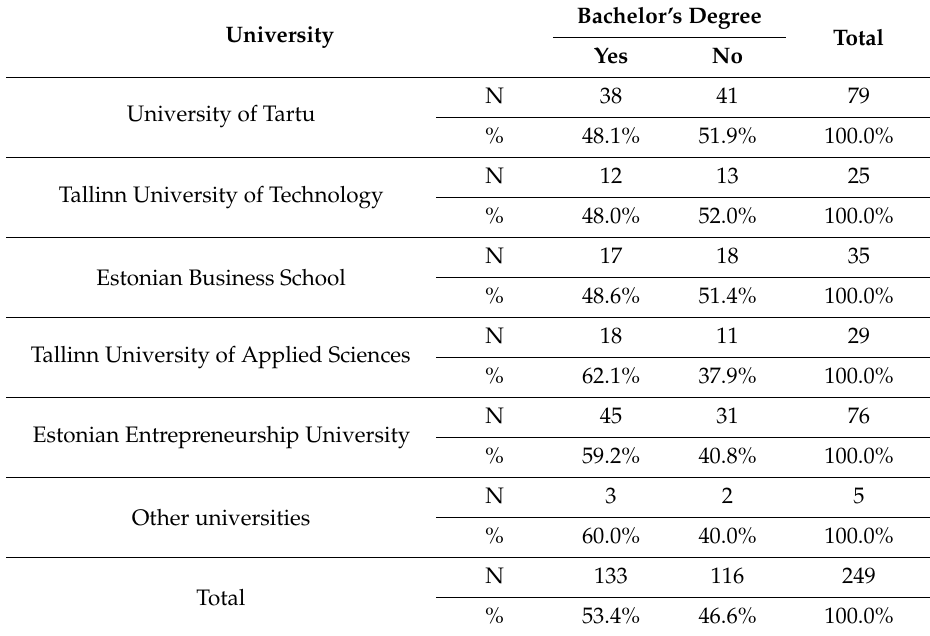
Table 1. Descriptive information about the